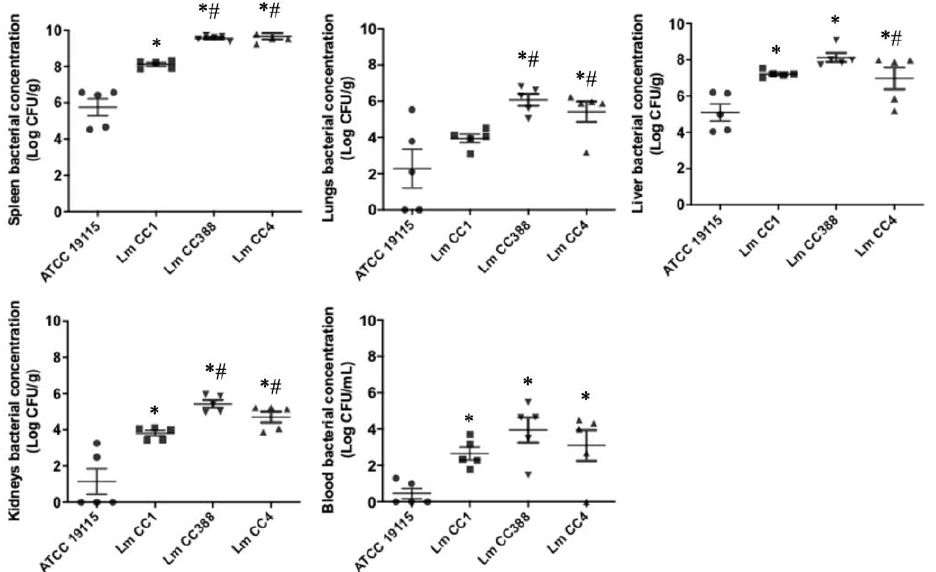
Figure 4. Bacterial burden in intravenous murine model by L. monocytogenes . Bacterial concentrations in spleen, lungs, liver, kidneys and in the murine model of peritoneal sepsis by L. monocytogenes Lm CC388, Lm CC1, Lm CC4 and ATCC 19115 strains at 5 log 10 CFU/mL. Data are represented as mean ± SEM. *: p < 0.05 versus ATCC 19115, #: p < 0.05 versus Lm CC1.